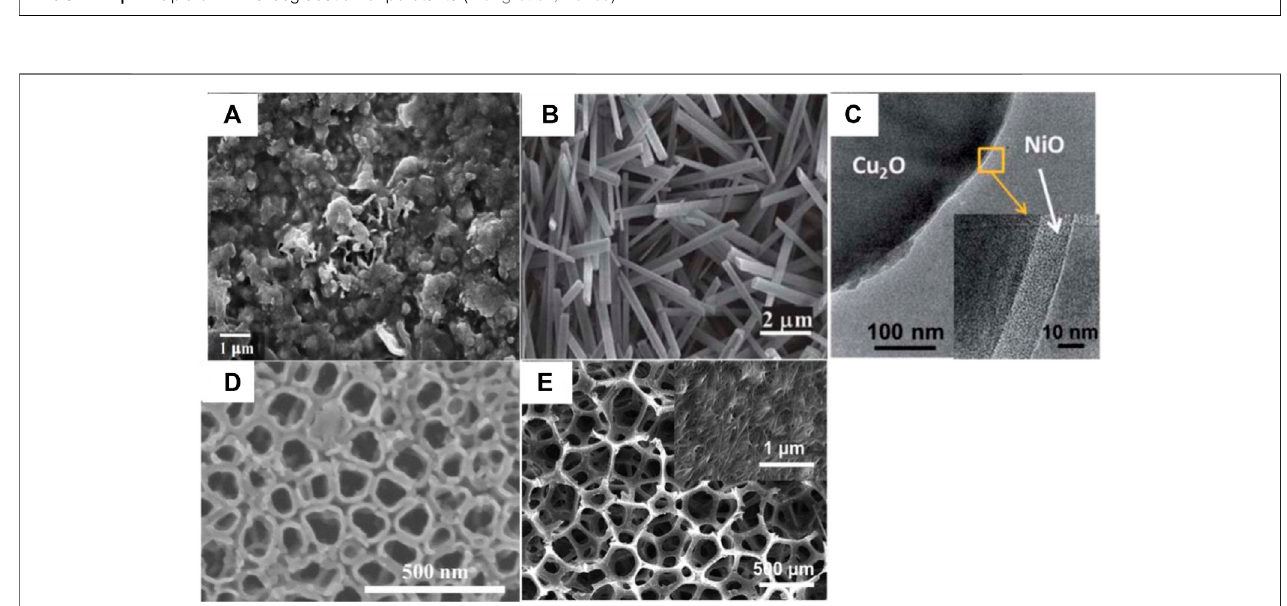
FIGURE 3 | Common nanostructured semiconductor cathodes: (A) Cu x O electrodes (Castresana et al., 2019); (B) Cu|nanoCu(OH) 2 and (C) Cu|nanoCu 2 O|NiOx (N = 3) electrode (Lin et al., 2012); (D) PDA/TiO 2 NTs (composed of polydopamine modi fi ed TiO 2 nanotubes) (Zeng et al., 2019); (E) Carbon nanotube (Xie et al., 2012).